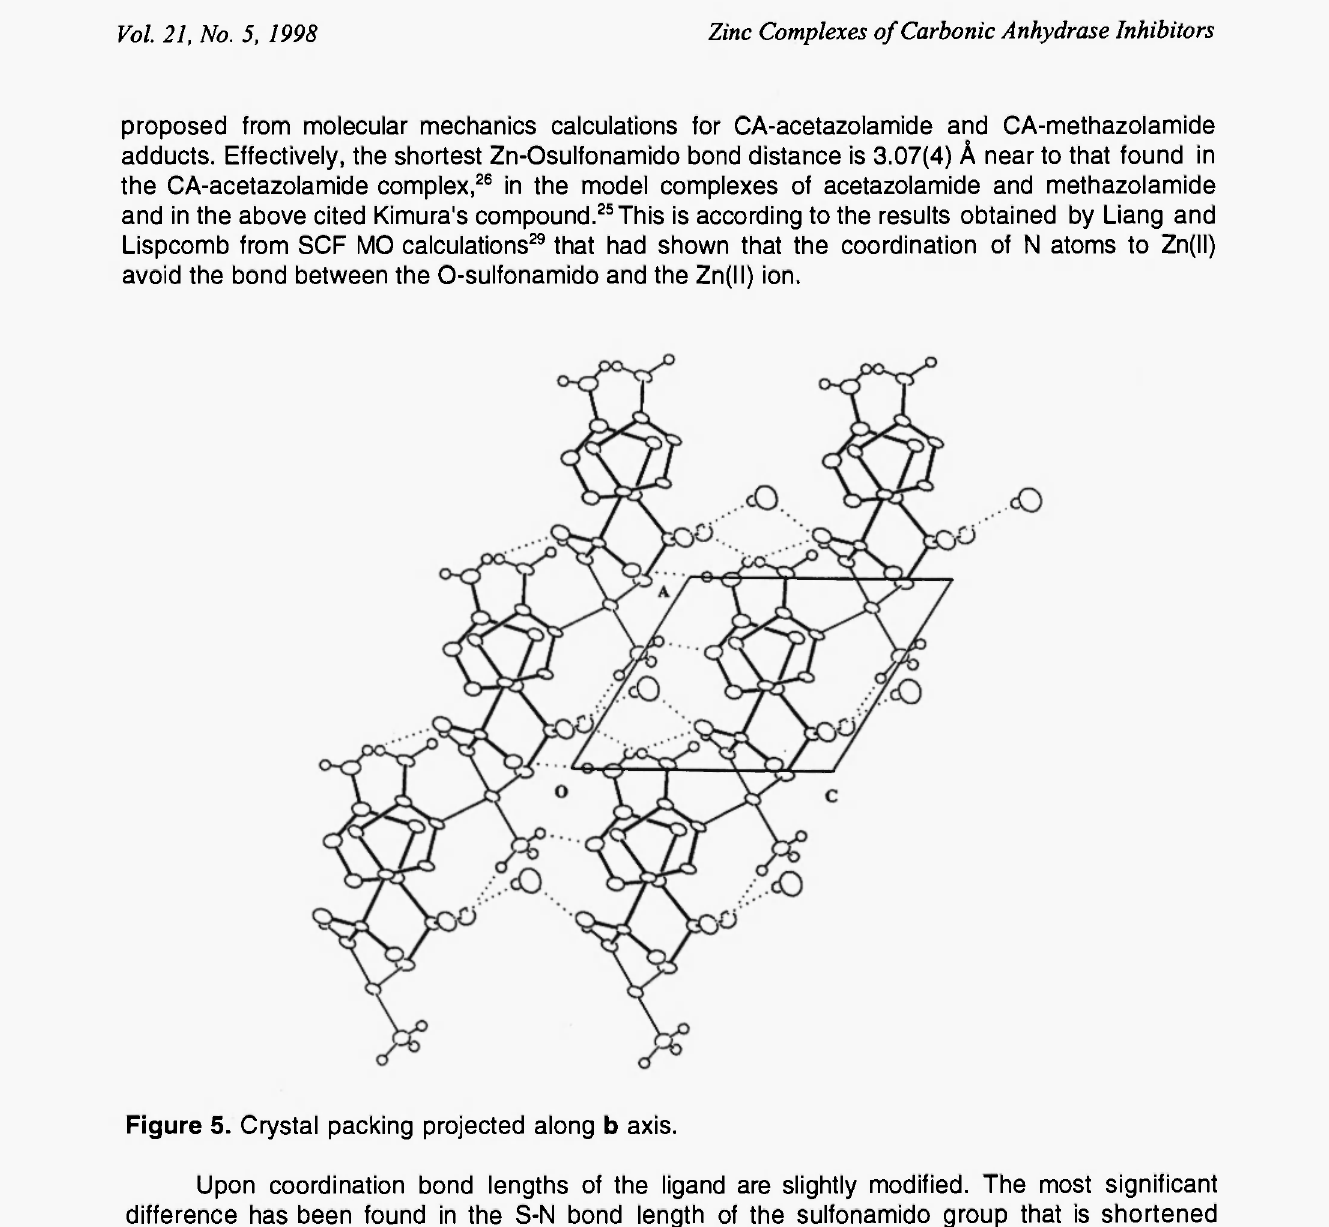
Figure 5. Crystal packing projected along b